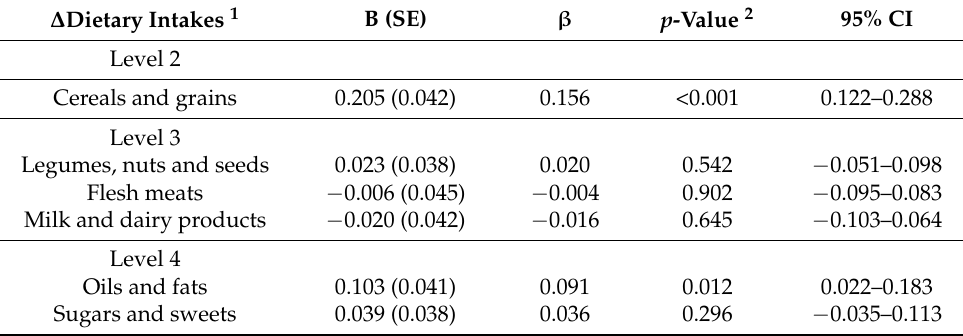
Table 6. Predictors of weight loss during the COVID-19